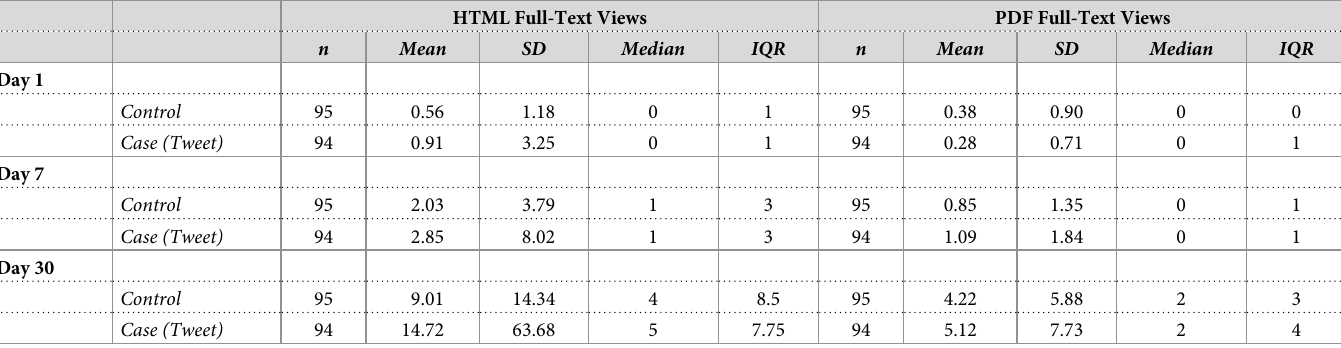
Table 1. Descriptive Statics Stratified by Page-View Metrics, Time Period, and Condition for a 2018 Study of the Effects of Journal Tweeting on article page views.